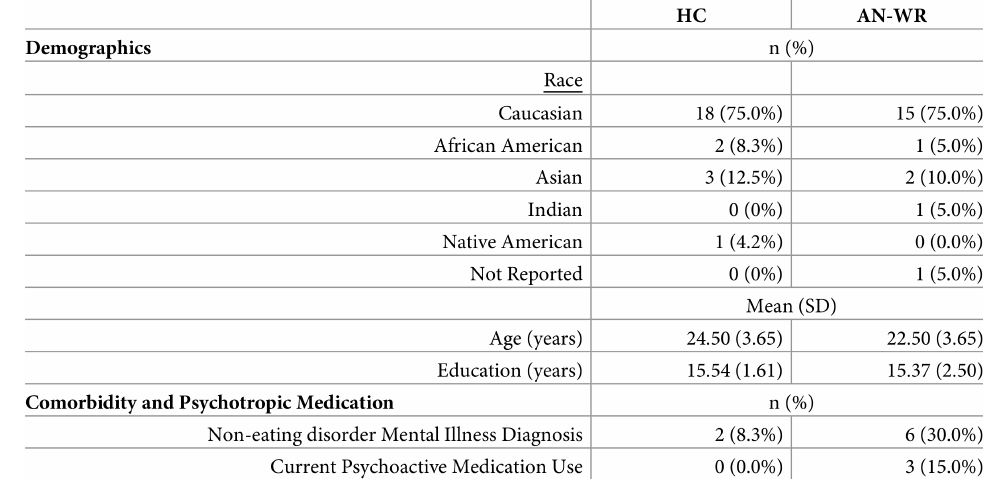
Figure 1. Demographic data of participants. Numbers reflect 24 members in the control group (HC) and 20 members in the clinical group (AN-WR)